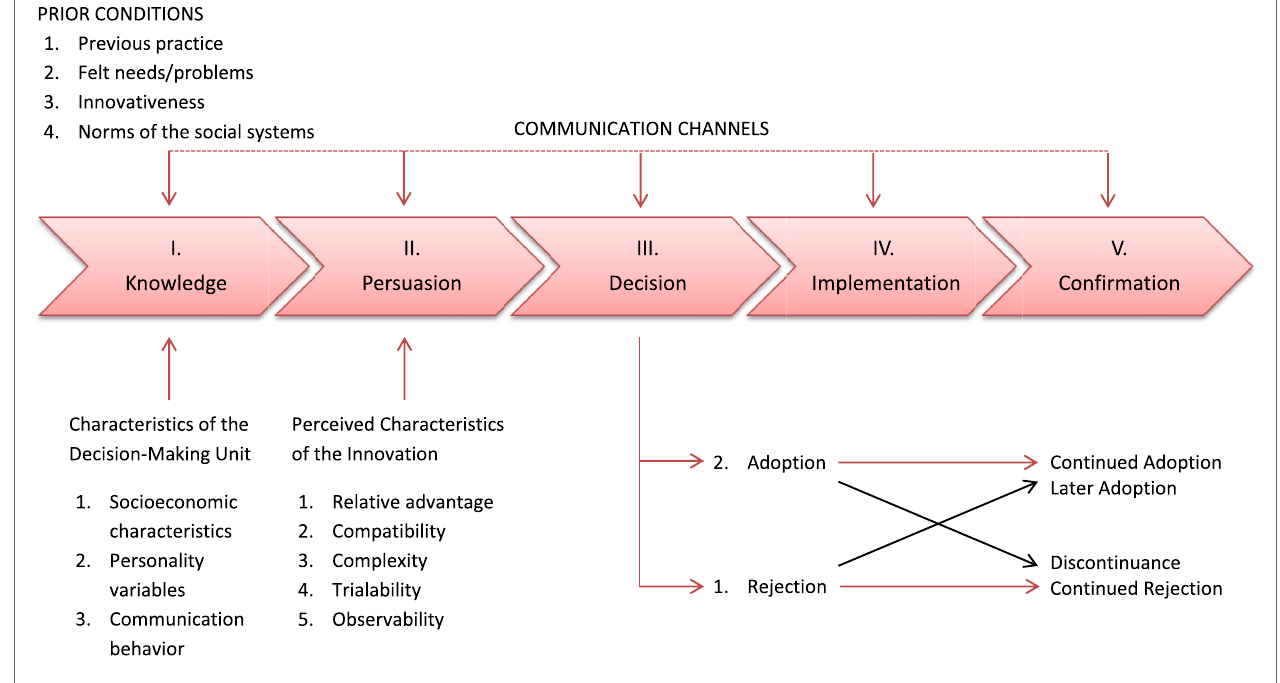
FigURe 3 | A model of stages in the innovation-decision process . According to the model, adoption or rejection of innovation proceeds through five consecutive stages. Source: Rogers (1995), p. 165. This is an adapted version of the original figure that is reproduced with the permission of the copyright